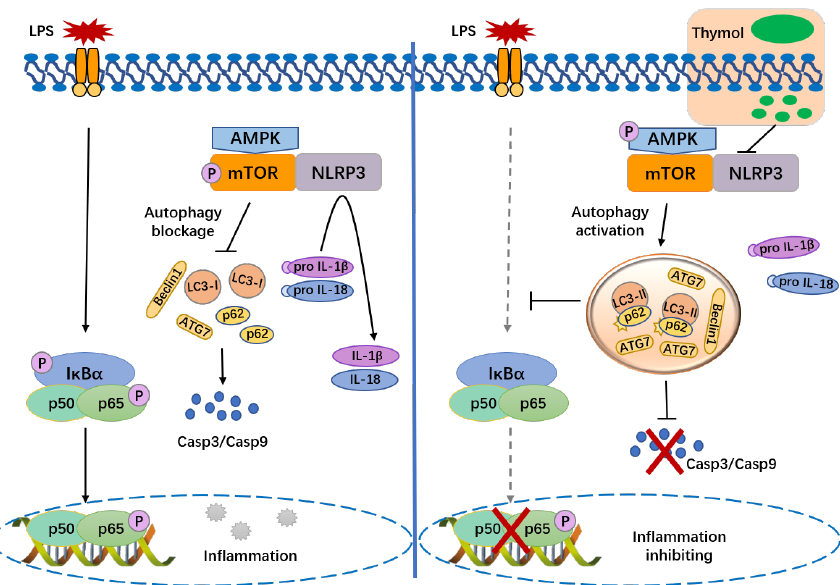
Figure 6. Interaction network of NLRP3 and autophagy after administration of thymol upon LPS challenge.